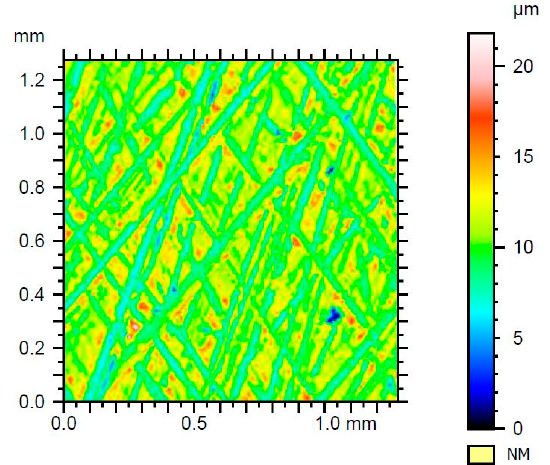
Figure 5. Measured roughness of sample no. 1 after filtration with Gaussian filter.